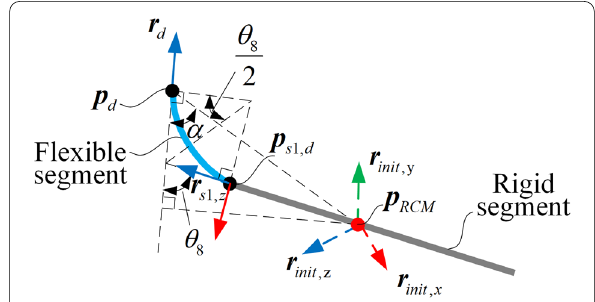
Figure 9 Motion of hysteroscope with RCM